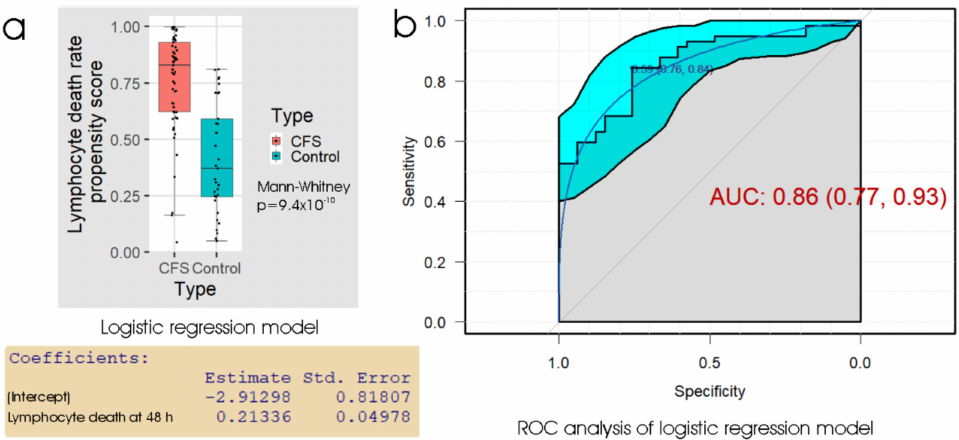
Figure 2. Logistic regression and ROC analysis of the percentage of dead lymphocytes after 48 h post-storage culture. ( a ) Box plot showing the distribution of the propensity score in logistic regression of the sample type against the fraction of dead lymphocytes observed after recovery from frozen storage and 48 h culture. The resulting regression coe ffi cients are as indicated. The boxes show the median and the 25 th and 75 th percentiles, so that the height of the box is the interquartile range (IQR). The whiskers extend to the most extreme observations (largest and smallest) falling within ± 1.5 × IQR of the box. The ME / CFS and control sample sizes were 57 and 33 individuals, respectively. The Mann–Whitney significance probability tests the hypothesis that the scores in ME / CFS samples are greater than in control samples. Scores greater than 0.5 lead to classification of a sample as ME / CFS in the “confusion matrix”. Other relevant statistics showing that the logistic regression model provided a good fit to the data were: Hesmer–Lemeshow goodness of fit = 0.11; Pseudo R 2 = 0.59; χ 2 p = 1.9 × 10 − 7 . ( b ) ROC analysis of the propensity score, plotting sensitivity (proportion of true positives) against specificity (proportion of true negatives) with 95% confidence limits (cyan shading). The fractional area under the curve (AUC) is shown with 95% confidence limits. The “best” threshold for the propensity score (0.59) is shown, together with the specificity (0.76) and sensitivity (0.84) at that threshold (in